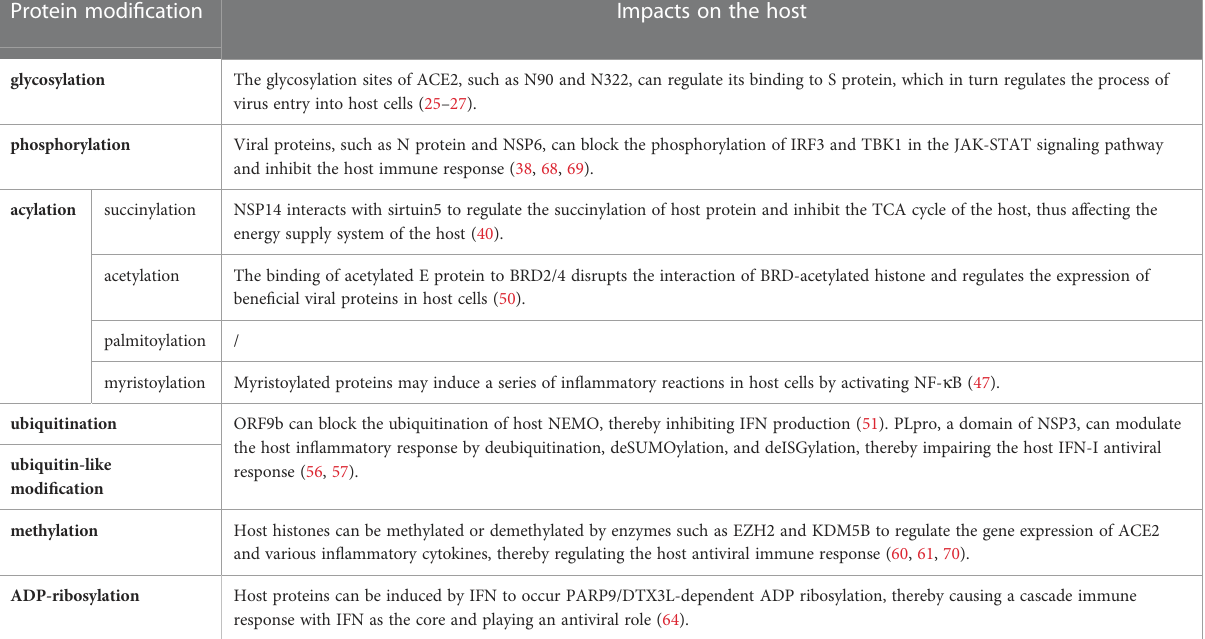
TABLE 2 Effects of post-translational modi fi cations of SARS-CoV-2 proteins on the host. Protein modi fi